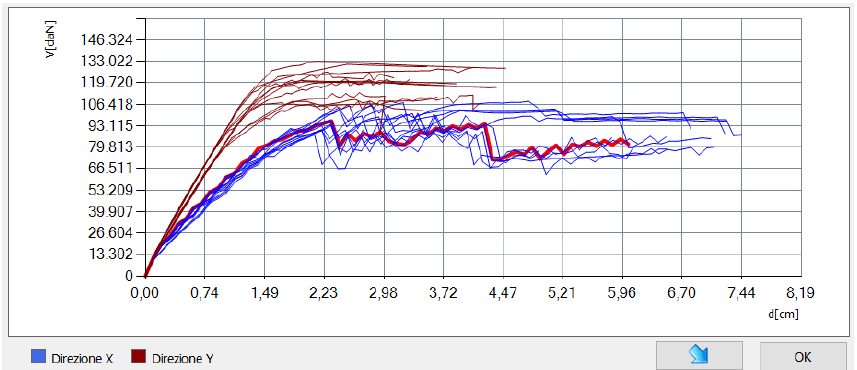
Figure 10. Base-shear displacement curves of the bare building derived from non-linear analyses.